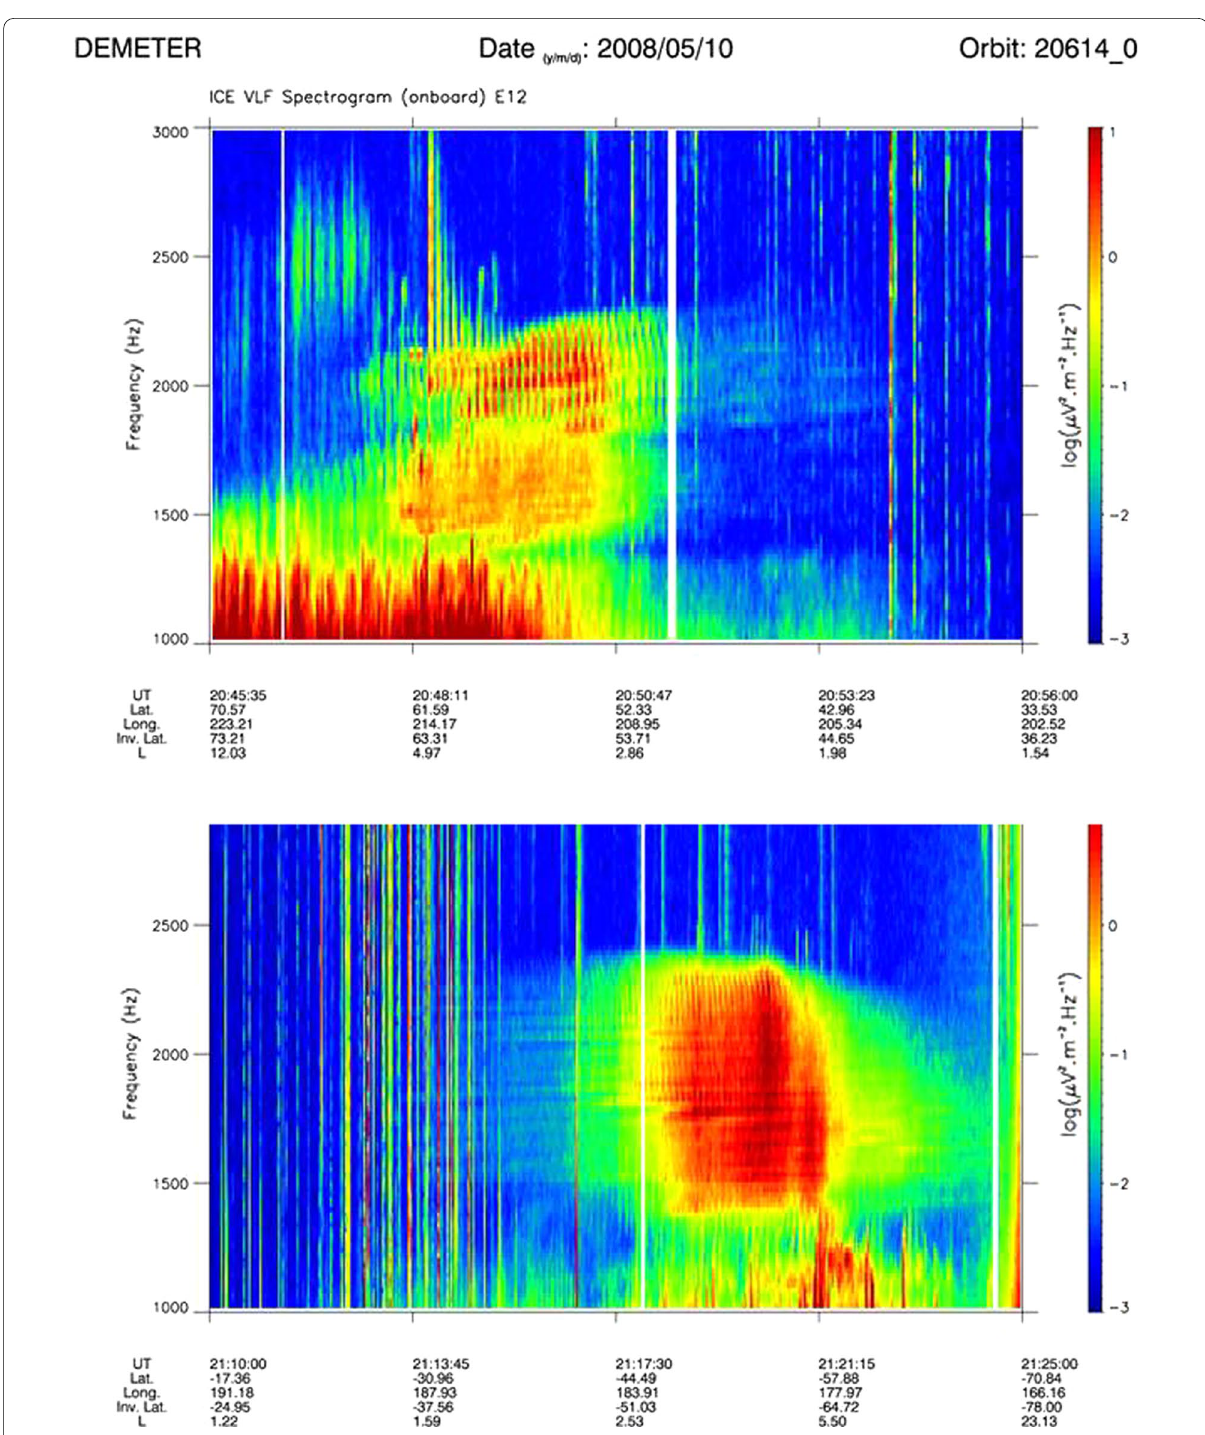
Fig. 19 Top panel: spectrogram of an electric component recorded onboard DEMETER in the Northern hemisphere between 20:45:35 and 20:56:00 UT, and in the frequency range 1–3 kHz. Bottom panel: same as in the top panel but the spectrogram is now recorded in the Southern hemisphere between 21:10:00 and 21:25:00 UT. The power spectral density is color-coded according to the scale on the right. The parameters below the panels indicate the UT, the geographical latitude and longitude, the invariant latitude, and the McIlwain parameter